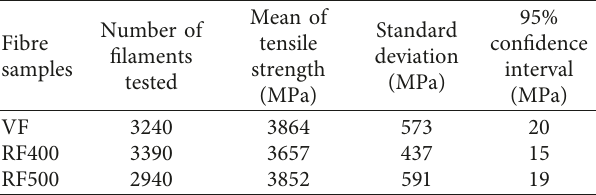
Table 4: Statistical parameters of normal distributions obtained from bundle tensile tests analysis and related 95% confidence